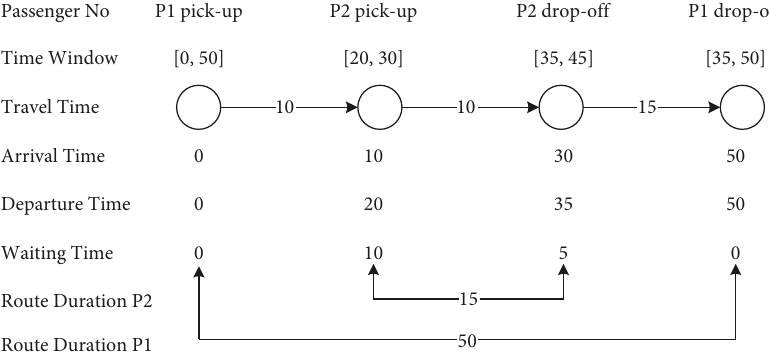
Figure 2: The instance without time slack calculation strategy.